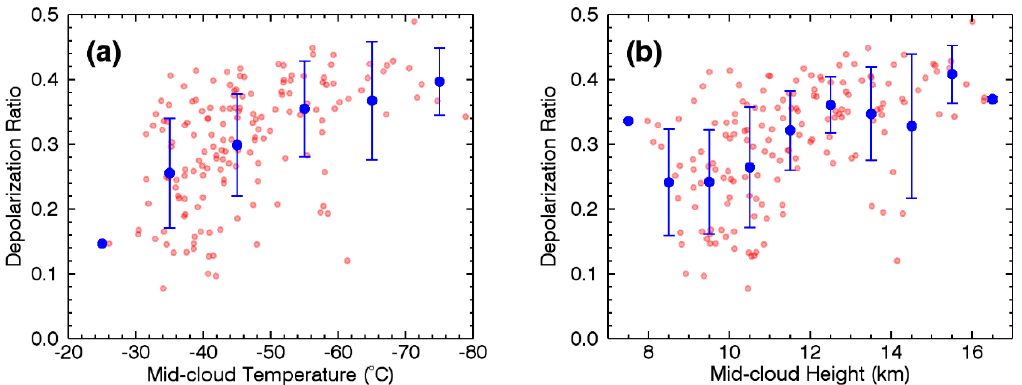
Figure 12. Scatterplots (red dots) showing the relationships between cirrus depolarization ratio, and ( a ) mid-cloud temperature and ( b ) mid-cloud height. Blue dots and vertical bars are the associated mean values and standard derivation grouped every 10 °C and 1 km respectively. Note that the cirrus depolarization ratio tends to increase with the lowering mid-cloud temperature.